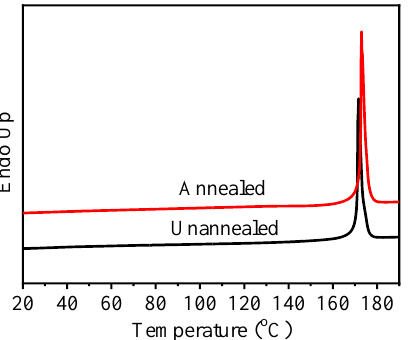
Figure 5. The first DSC melting curves of the unannealed and annealed films.